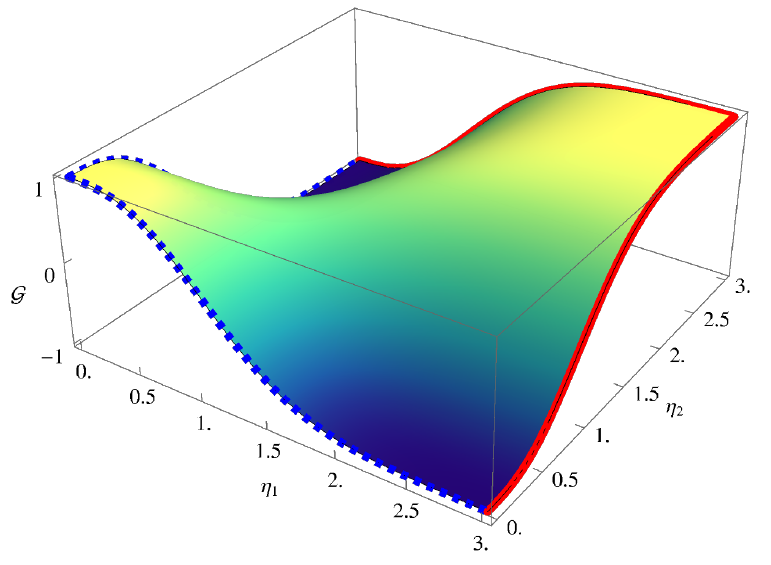
Figure 4. The function G ( η 1 , τ 1 ; η 2 , τ 2 ) with τ 1 = − τ 2 = 0 . 1 . The solid red curves and the dashed blue curves correspond to the droplet profiles ± Υ( χ 1 ) and ± Υ( χ 2 ) ,